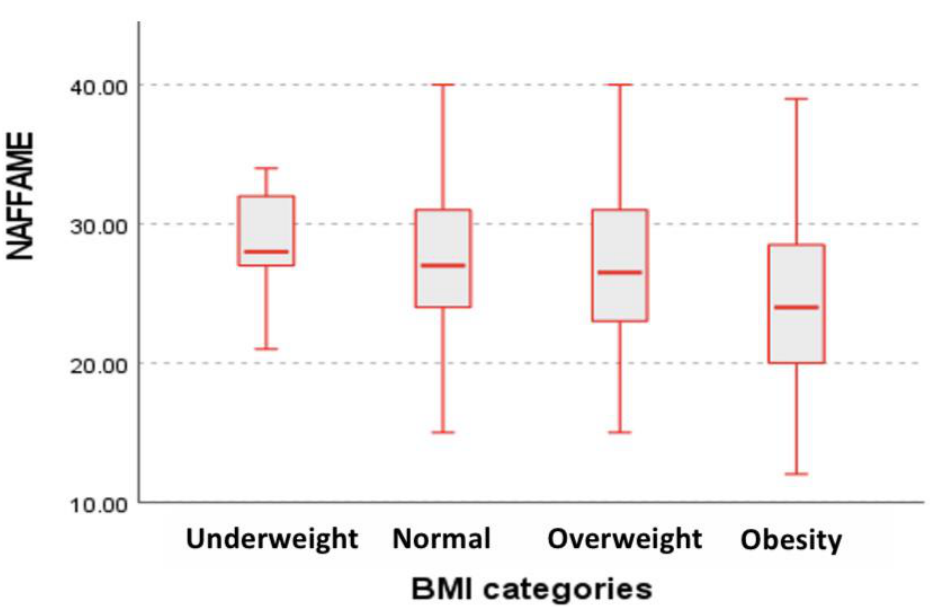
Figure 2. Independent-samples Kruskal–Wallis test showing the means of NAFFAME in different BMI categories. BMI